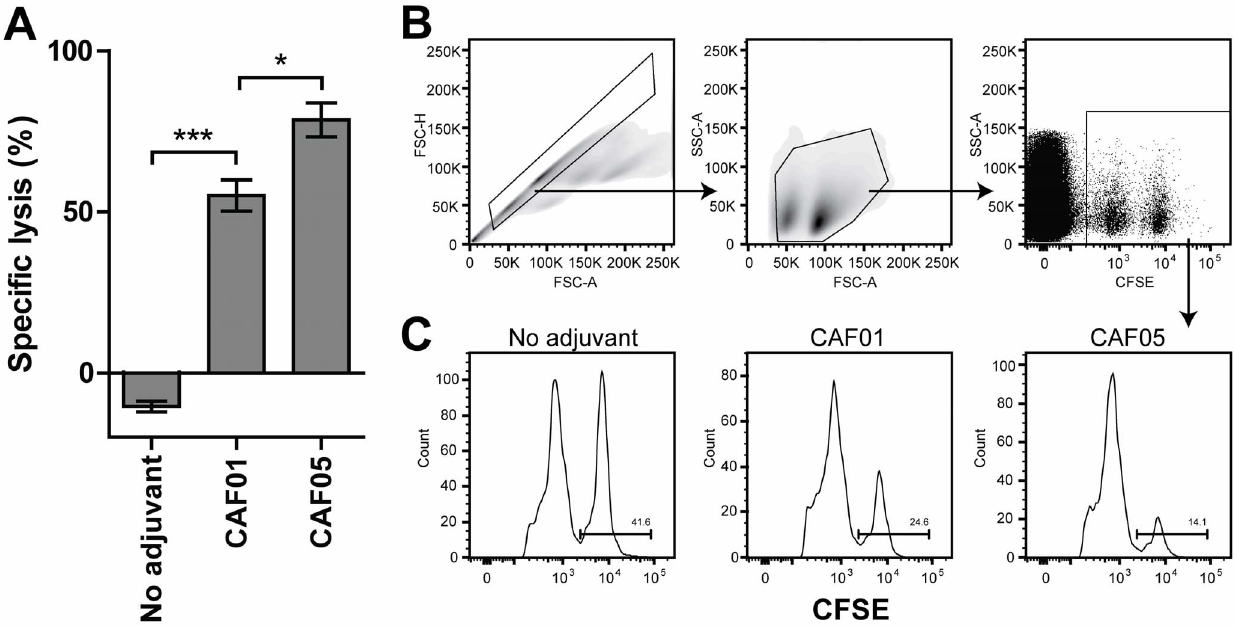
Figure 3. The CAF05 adjuvant enhances the cytotoxicity of CD8 T cells. Mice were immunized three times i.p. with 20 m g Gag p24 protein alone (‘no adjuvant’) or adjuvanted in either CAF01 or CAF05. Three weeks later in vivo cytotoxicity was determined 1 day after adoptive transfer of AMQMLKETI-pulsed (CFSE hi ) or unpulsed (CFSE lo ) CFSE-stained target cells from naı¨ve mice. (A) The specific lysis relative to the naı¨ve control group. Bars represent the mean specific lysis of individual mice within each group (n=3/4 + / 2 SEM). Significant differences as determined by one-way ANOVA followed by Tukey’s post test have been indicated: * p , 0.05, *** p , 0.001. (B) Gating strategy for one representative mouse. (C) Representative histograms of CFSE lo and CFSE hi populations for all three immunization groups.